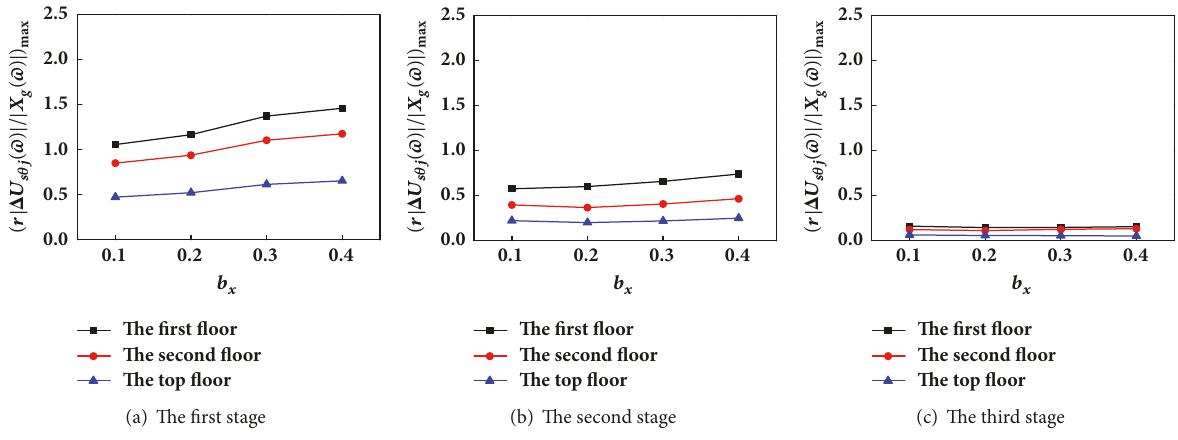
Figure 17: Interstory torsion displacement under different 𝑏 𝑥